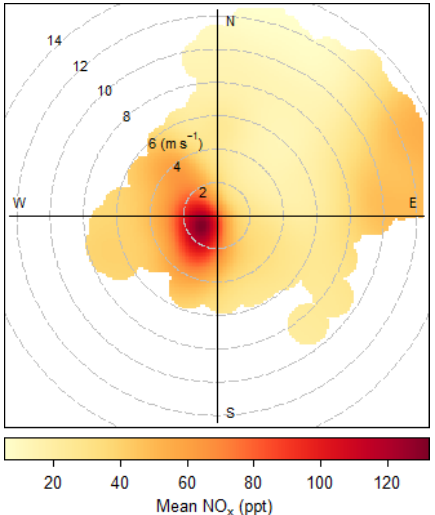
Figure 4. Total NO x from June 2017 to August 2019 plotted as a function of wind speed and